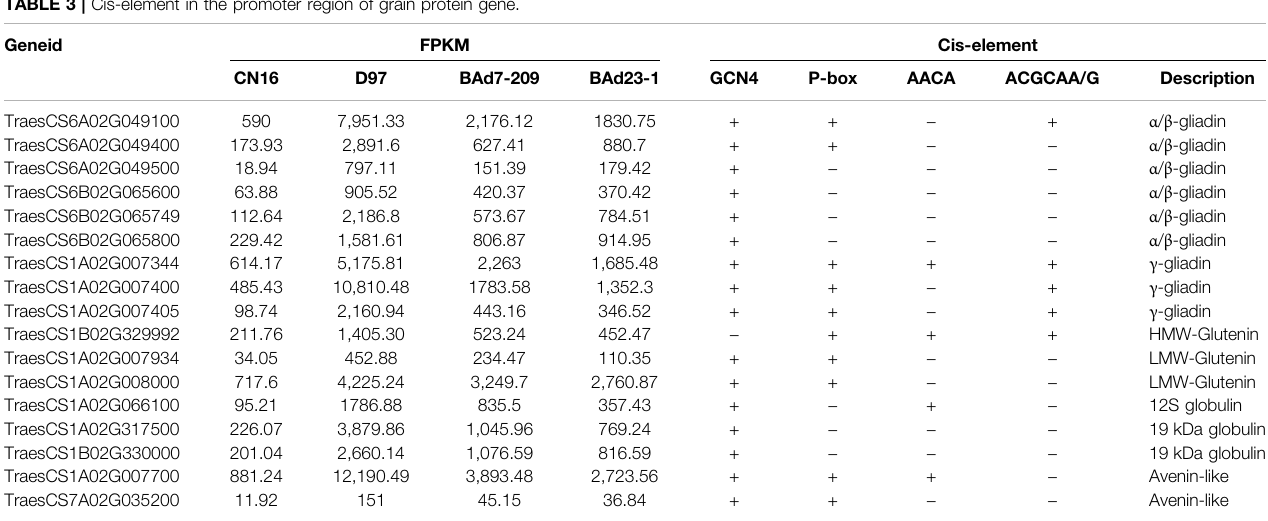
TABLE 3 | Cis-element in the promoter region of grain protein gene.